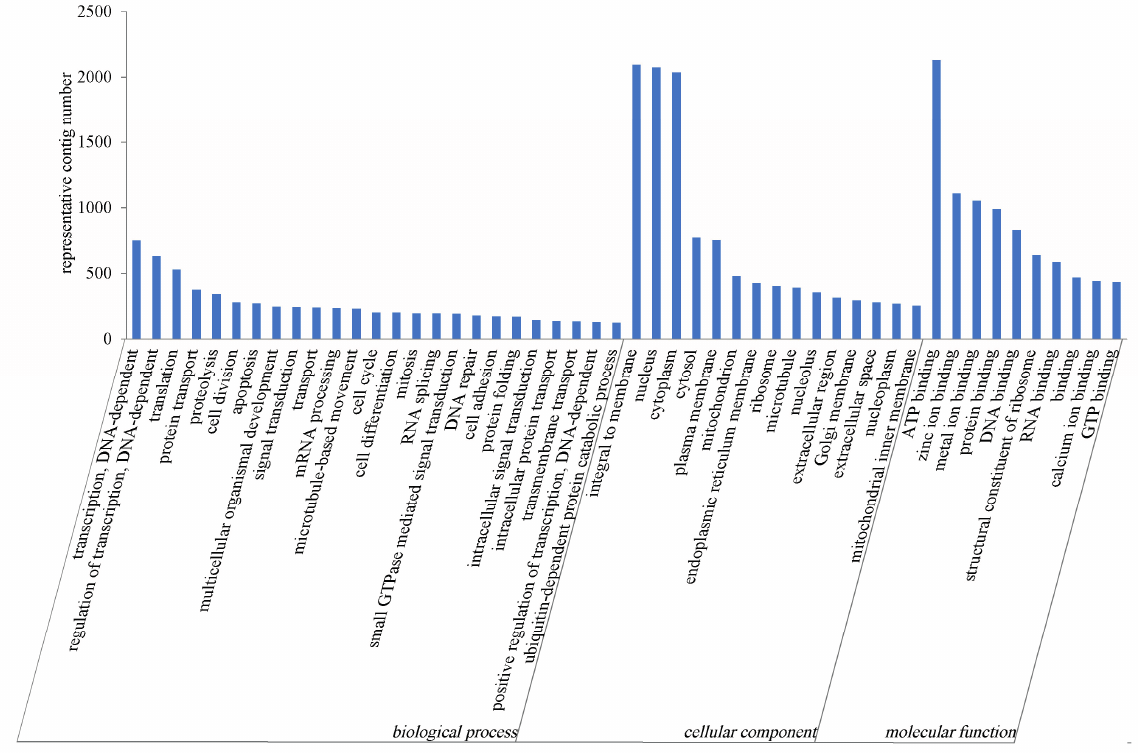
Figure 4. Classification of the gene ontology (GO) for the sea cucumber coelomocytes transcriptome representative